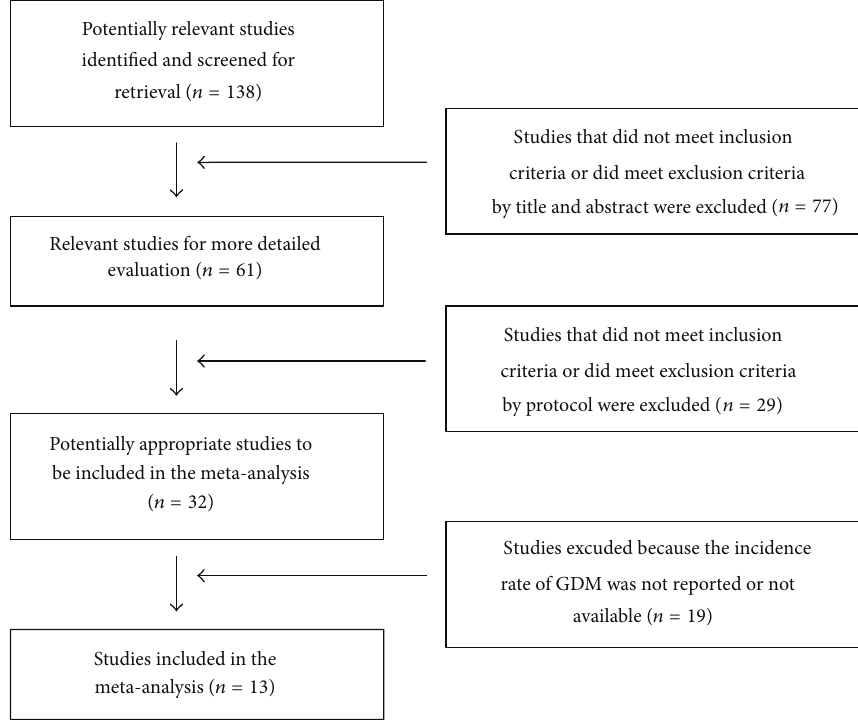
Figure 1: Flowchart of the study